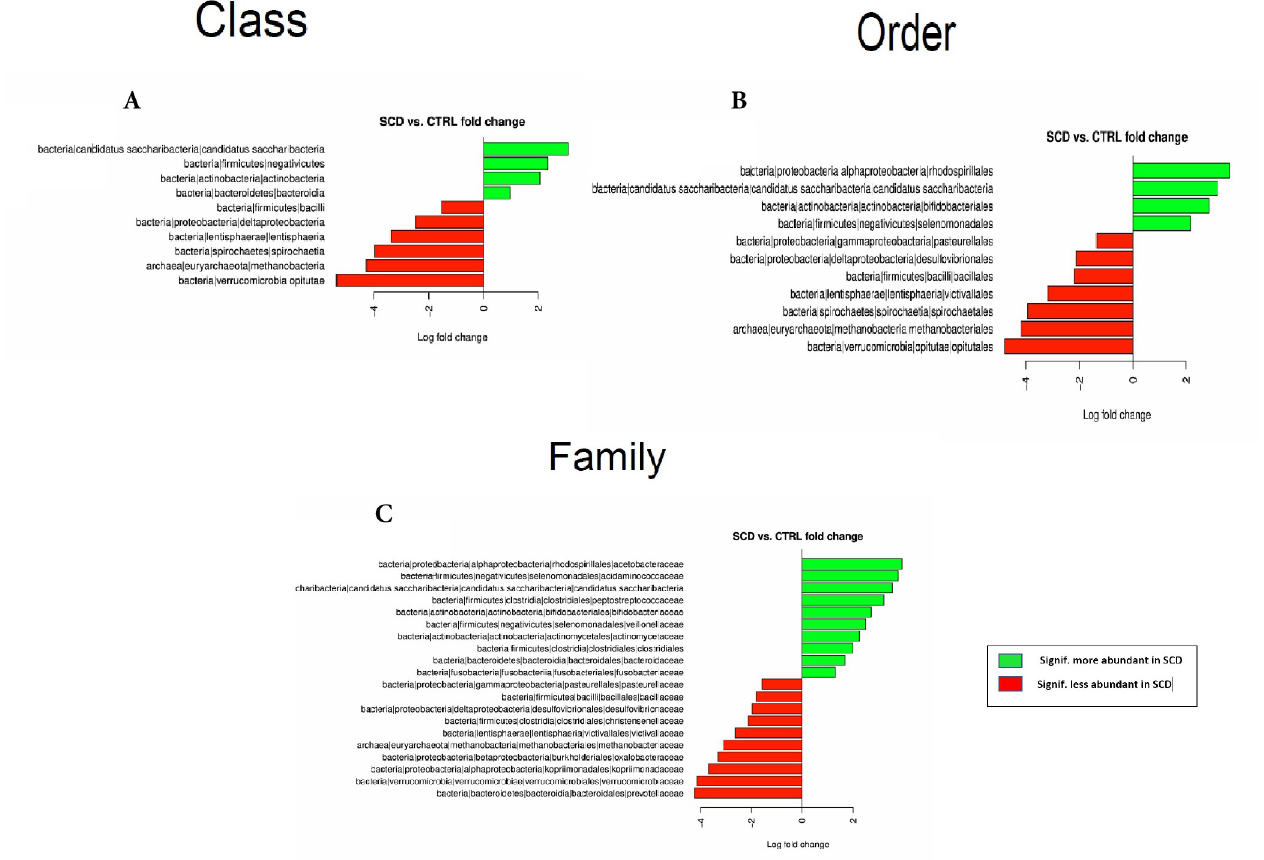
Fig 1. Differential bacterial Classes (A), Orders (B) and Families (C) between SCD subjects and healthy controls’ stool samples.